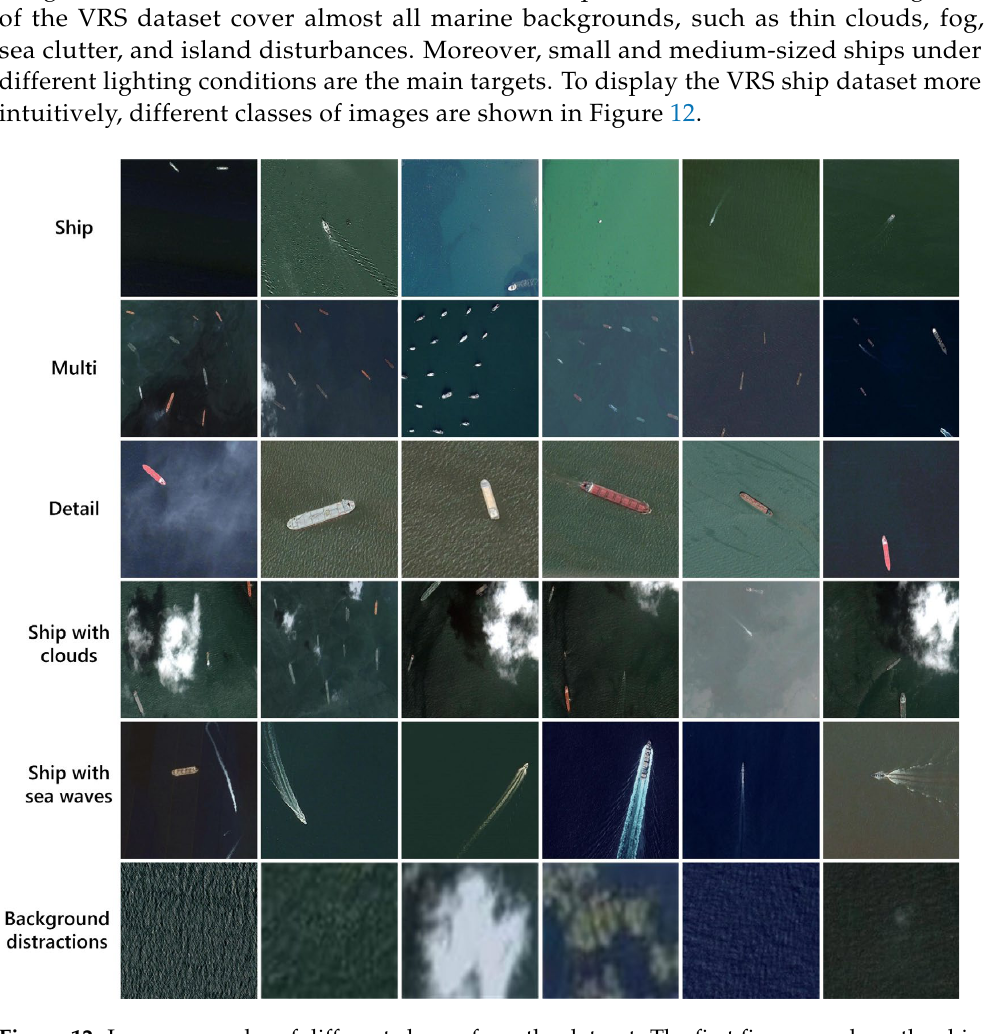
Table 1. Comparison of different optical remote sensing datasets.